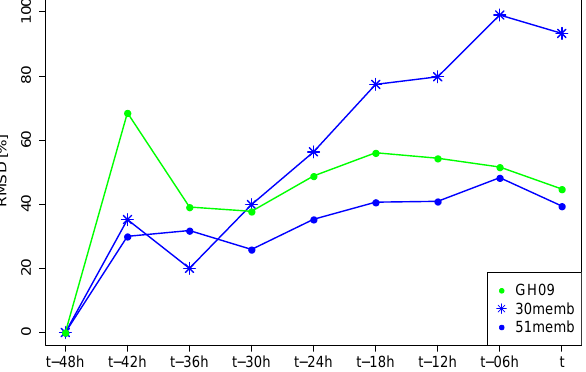
Fig. 5. Time serie of the mean normalized RMSD of the MSLP field between perturbed and control simulations over 5 verification case